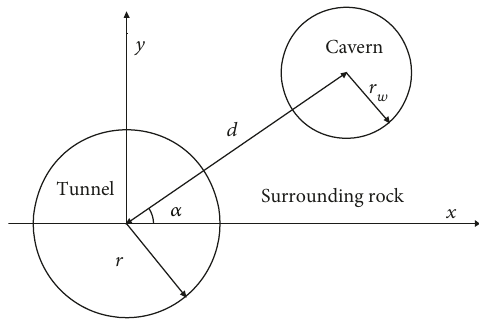
Figure 1: Schematic diagram of the karst tunnel in an in fi nite